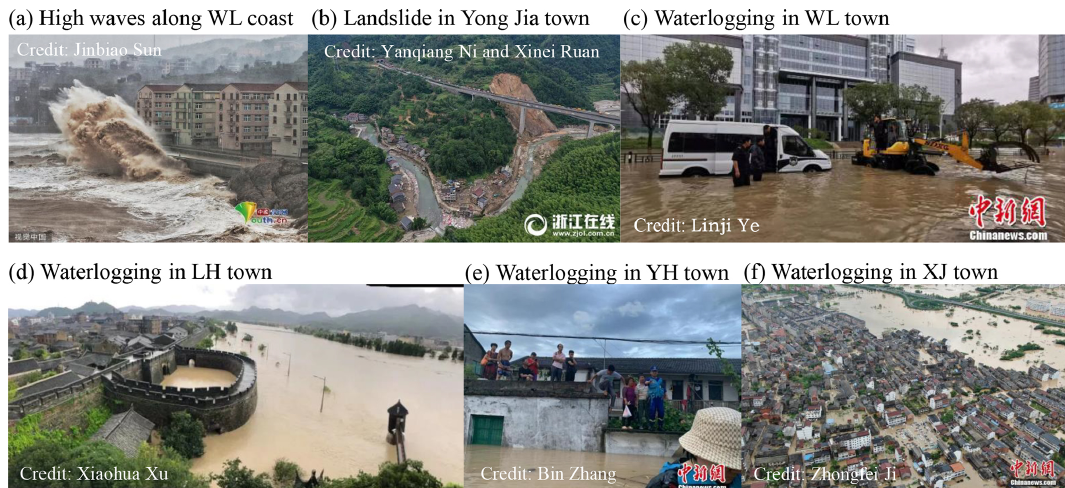
Figure 1. The disastrous situation in WZ and TZ due to the landfall of super typhoon Lekima: (a) high waves along the Wen Ling (WL) coast of TZ city; (b) landslide in the northern mountain area of Yong Jia (YJ) in WZ city; (c–f) serious waterlogging in WL, Lin Hai (LH), Yu Huan (YH), and Xian Ju (XJ) town of TZ city. Photo (a) is available at http://picture.youth.cn/qtdb/201908/t20190810_12036586. htm (last access: 15 January 2023). Photo (b) is available at https://baijiahao.baidu.com/s?id=1641647981934061656&wfr=spider&for= pc (last access: 15 January 2023). Photo (c) is available at https://new.qq.com/omn/20190810/20190810A0FZUT00.html?pc (last access: 15 January 2023). Photo (d) is available at https://new.qq.com/omn/20190828/20190828A0KGLT00.html (last access: 15 January 2023). Photo (e) is available at https://www.newssz.com/sz/2019/0818/94241-1/ (last access: 15 January 2023). Photo (f) is available at https: //m.chinanews.com/wap/detail/undefined/zw/8925613.shtml (last access: 15 January